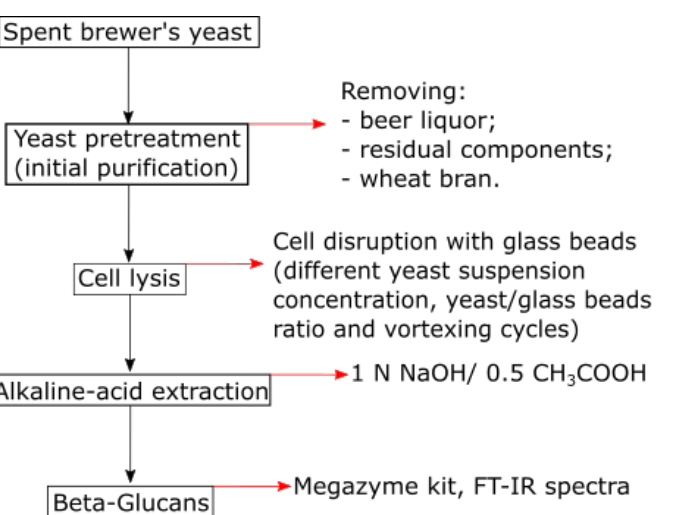
Figure 1. β –glucan extraction protocol from spent brewer’s yeast with the use of glass beads for cell lysis.